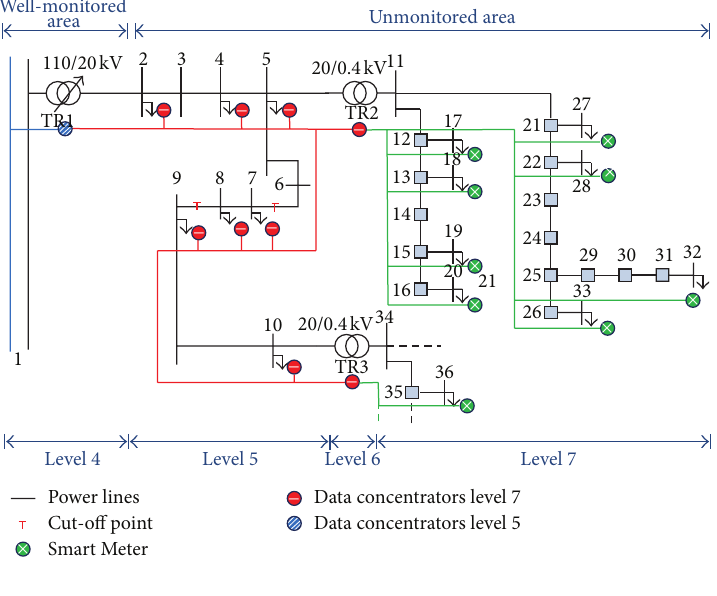
Figure 9: Hierarchical